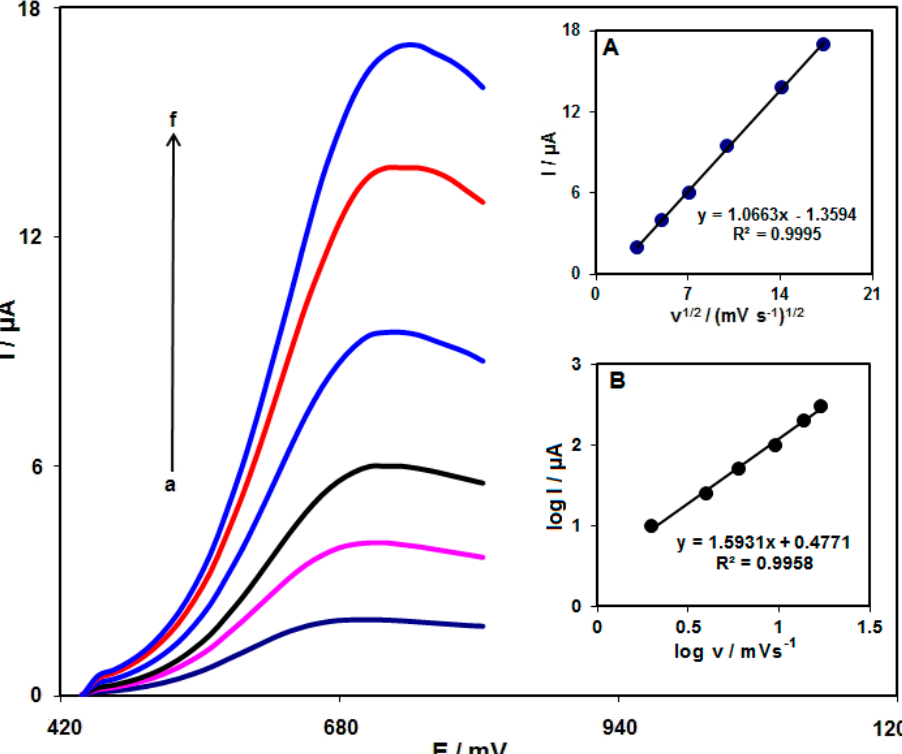
Figure 8. LSVs captured for the oxidation of sunset yellow (60.0 µM) on the NiCo 2 O 4 /SPGE under variable scan rates (a: 10 mV/s, b: 25 mV/s, c: 50 mV/s, d: 100 mV/s, e: 200 mV/s, and f: 300 mV/s). Insets: ( A ) the correlation of Ipa with ν 1/2 . ( B ) Variation of logarithm of current as a function of variation in the logarithm of scan rate. A Tafel plot (Figure 9 (Inset)) was achieved on the basis of data related to the rising domain of the current–voltage curve at a low scan rate (10 mV/s) for sunset yellow (60.0 µM) to explore the rate-determining step. The linearity of E vs. log I plot clarifies the in- volvement of electrode process kinetics. The slope from this plot could present the count of transferred electrons during the rate-determining step. Based on Figure 9 (inset), the Tafel slope was estimated to be 0.1309 V for the linear domain of the plot. The slope of the Tafel plot was equal to 2.3RT/n(1 −α )F, and the Tafel slope based on Figure 9 (inset) was estimated to be 0.1309 V for the linear domain of the plot. The Tafel slope value re- veals that the rate-limiting step is the one-electron transfer process, considering a trans- fer coefficient ( α ) of 0.55.